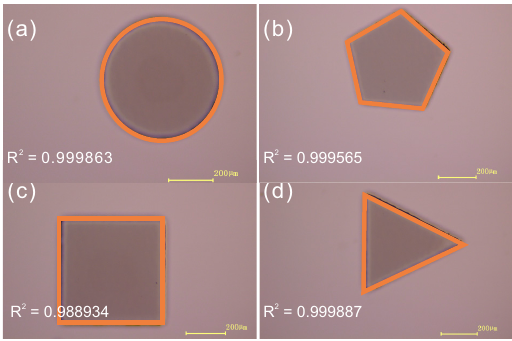
Figure 4. The patterns of circle ( a ); pentagons ( b ); squares ( c ); and triangles ( d ) fabricated by this technique and their correlation coefficients ( R 2 ).